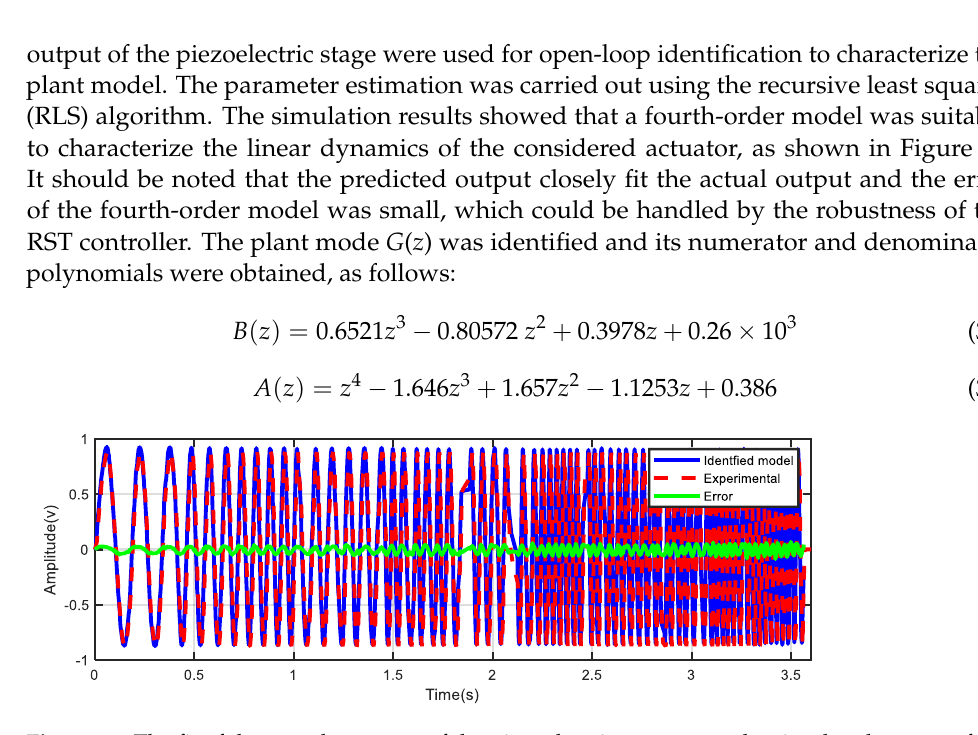
Figure 12. The fit of the actual response of the piezoelectric actuator to the simulated output of the identified transfer function.